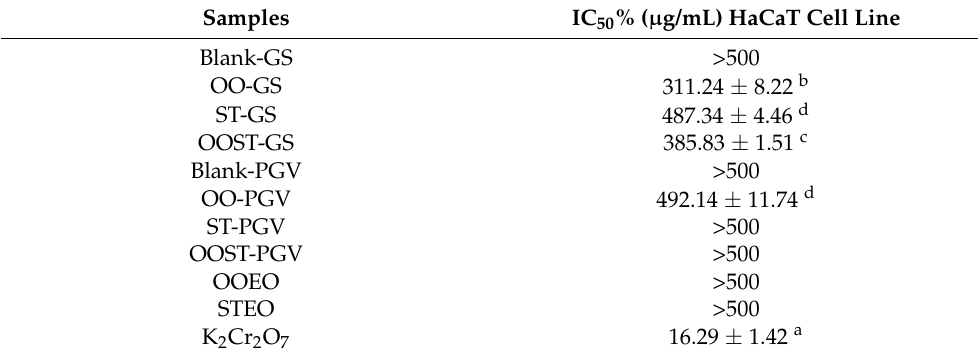
Table 7. Cytotoxic properties of pure and formulated of pure and formulated EOs of O. onites (OOEO) and S. thymbra (STEO) on human immortalized keratinocyte cell